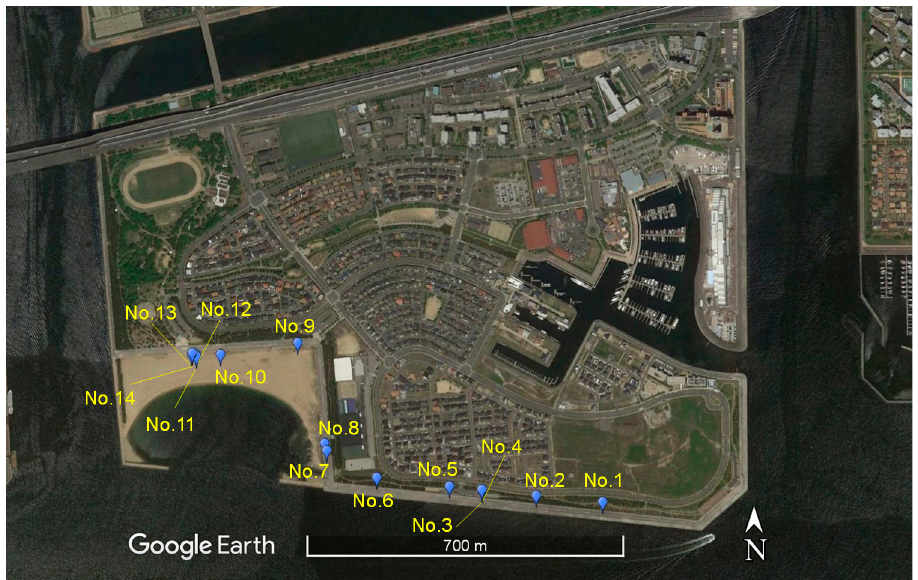
Figure 9. Bird’s eye view of the reclaimed land of Ashiya City and the location of the containers, whose coordinate are shown in Table 3.